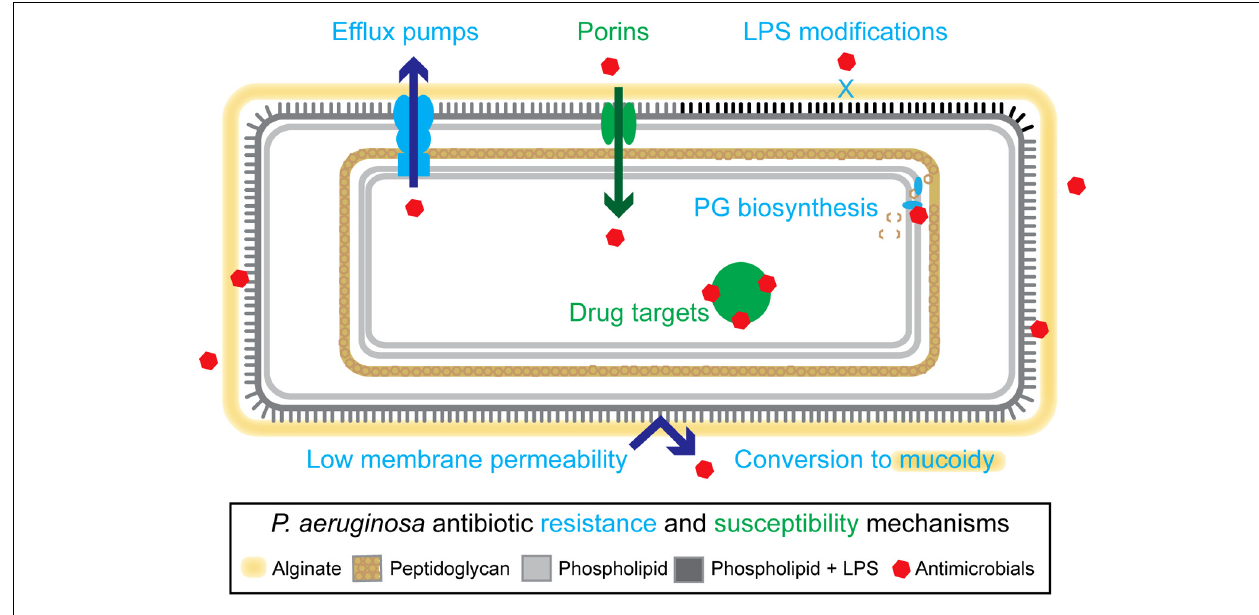
FIGURE 1 | Overview of resistance mechanisms in Pseudomonas aeruginosa . P. aeruginosa have a variety of intrinsic and adaptive resistance mechanisms including: a highly impermeable membrane, conversion to mucoidy, active efflux of antimicrobials, reduction of outer membrane porins, lipopolysaccharide (LPS) modifications, and